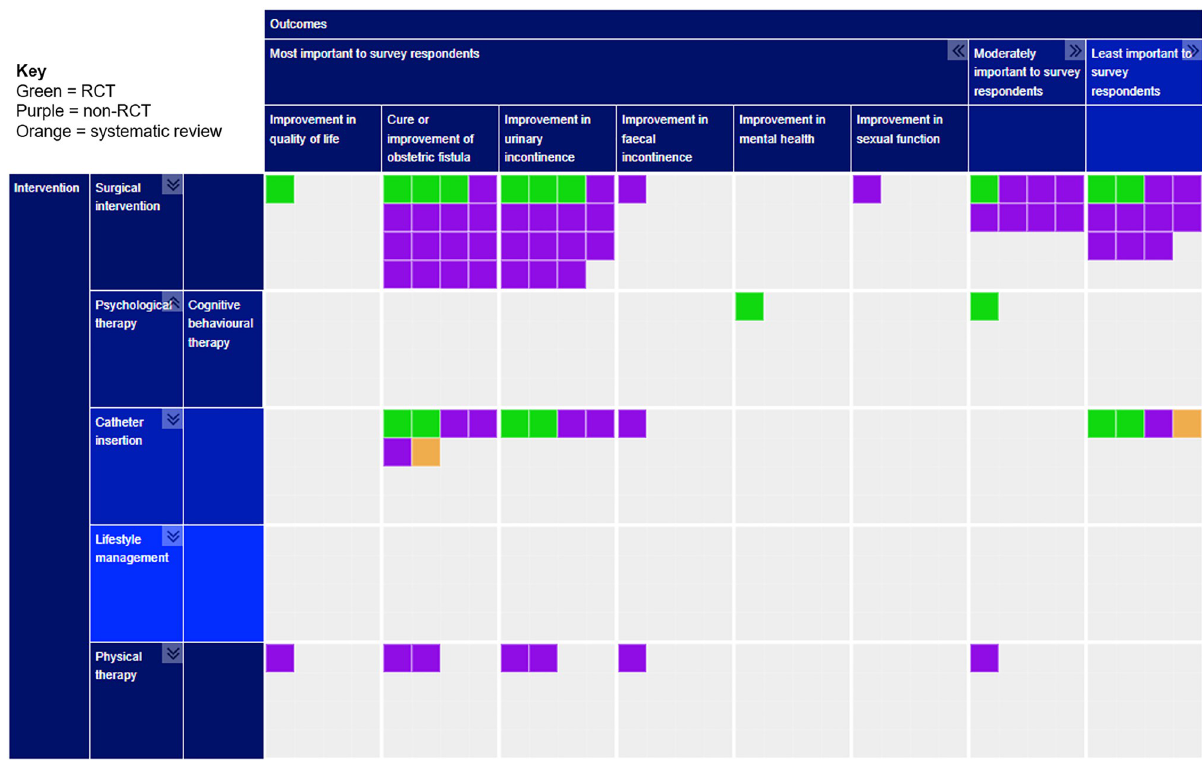
Fig 4. Evidence map of interventions for treating obstetric fistula. Key: Type of study: Green = RCT; Purple = Non-RCT; Orange = Systematic Review.